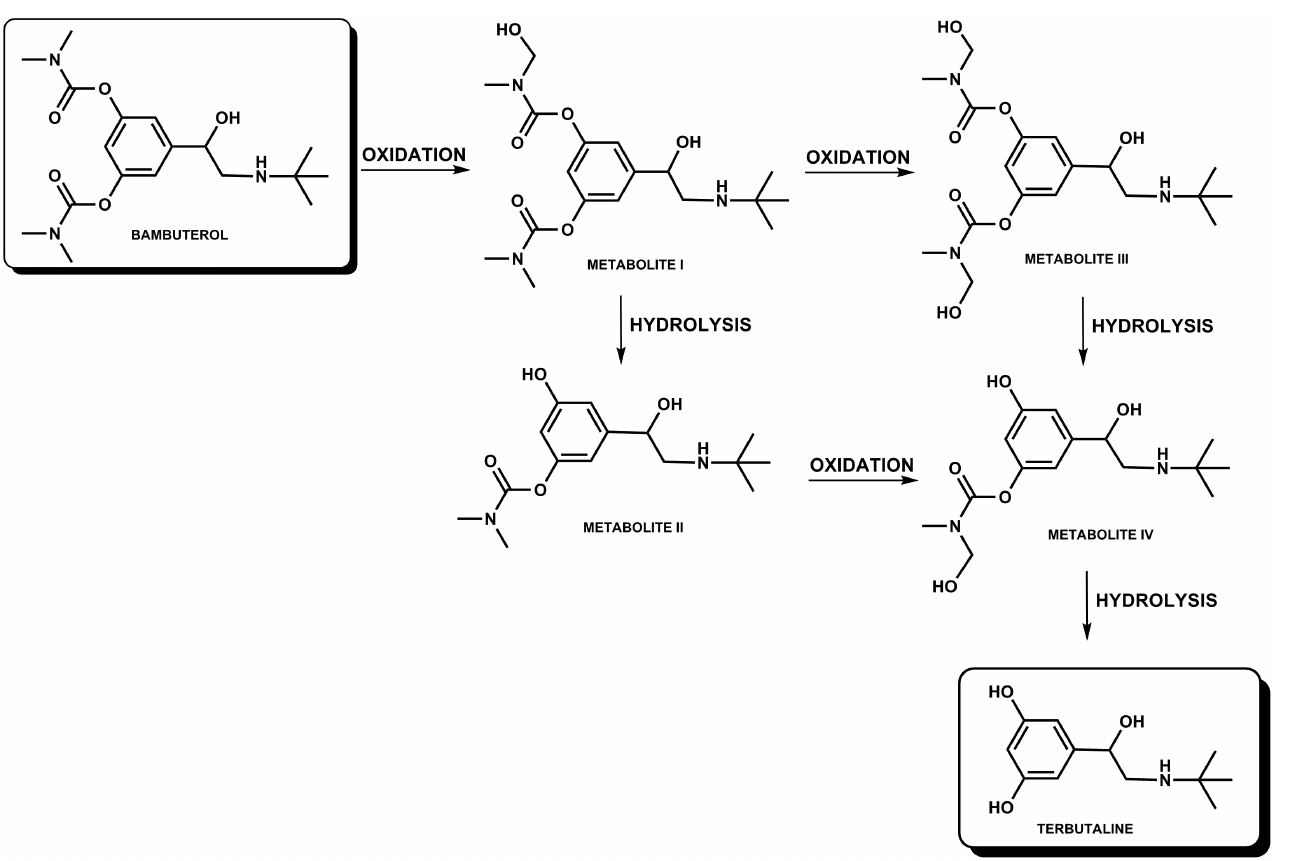
FIGURE 28 - Hydrolytic and oxidation metabolic conversion of bambuterol into